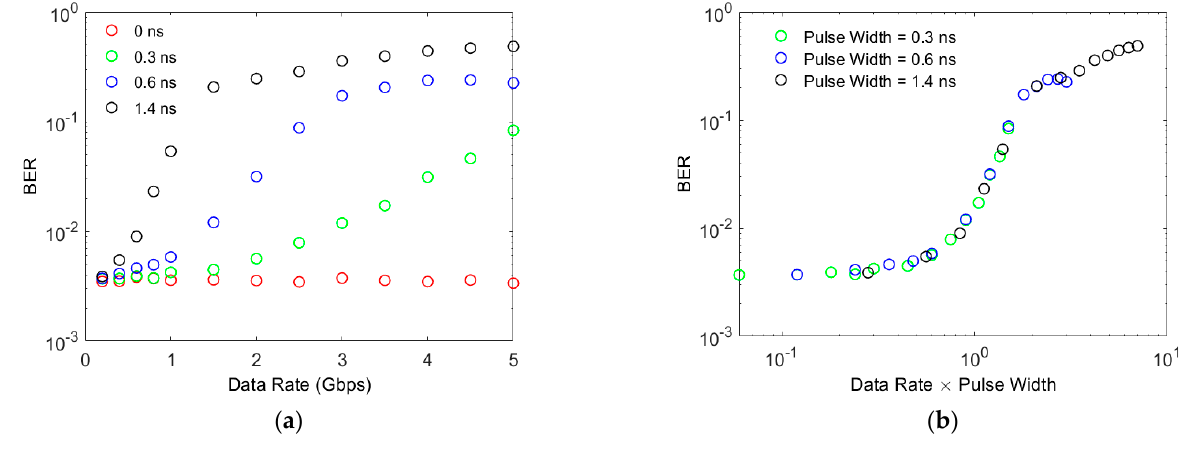
Figure 5. The BER achieved when 5.2 photons are detected per bit when a one is transmitted. ( a ) shows the results at different data rates compared to the ideal result. ( b ) shows that the important parameter is the product of the pulse width and the data rate.